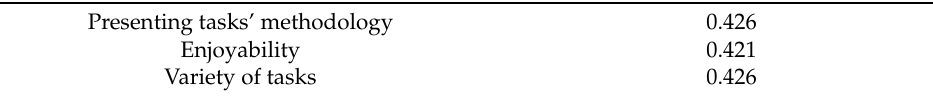
Table 4. Variables highly correlated with the quality of videos.